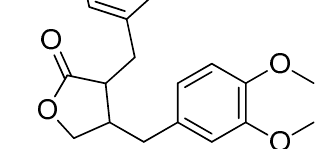
( b ) ( c ) Figure 22. ( a ) Arctigenin-L-methionine; ( b ) arctigenin-L-phenylalanine; ( c ) arctigenin-L-valine.